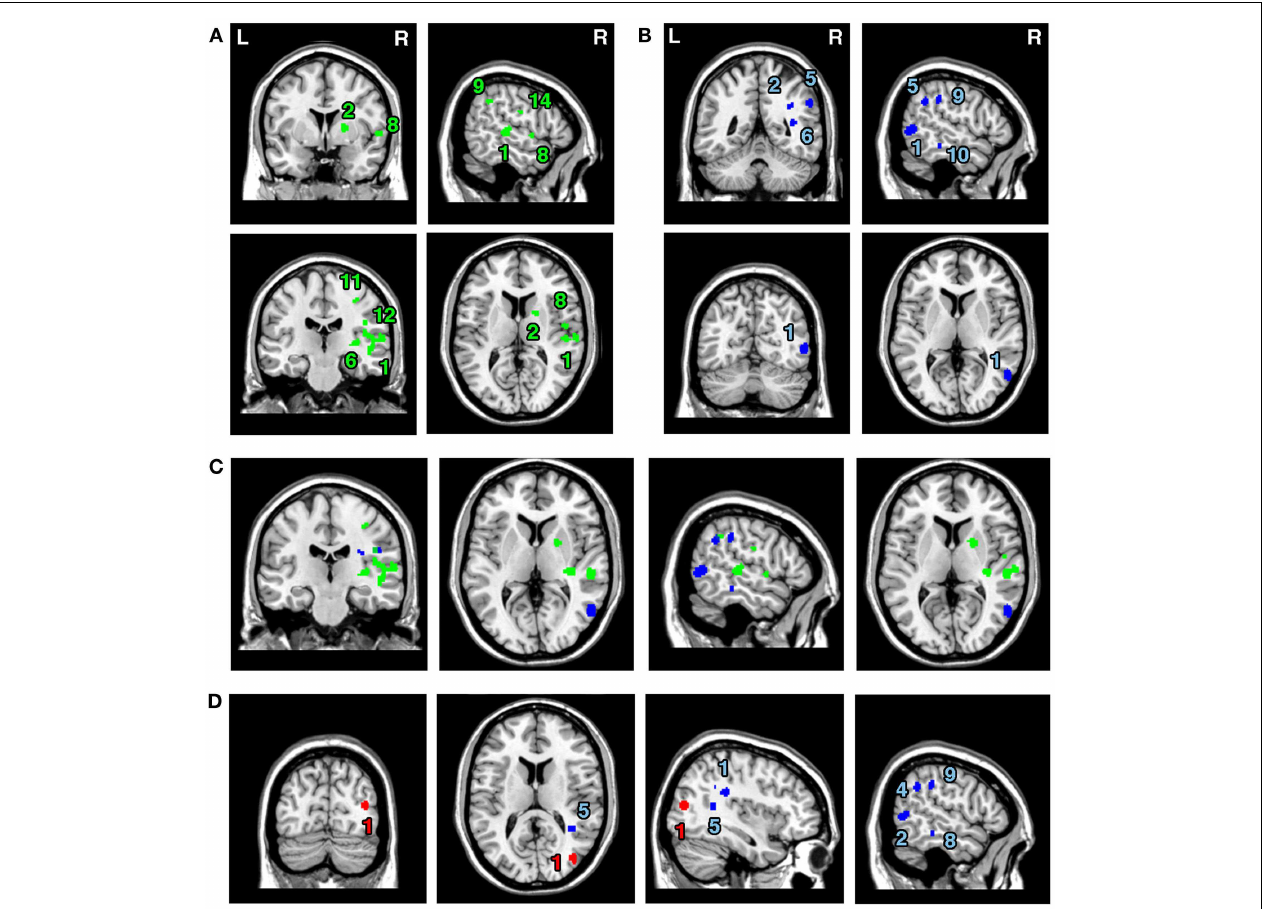
Distribution of ALE clusters indentified in both analyses ( Analysis 2 in green and Analysis 3 in blue). (D) The concurrence in lesions associated with either impaired performance on line bisection (red; Analysis 4 ) or impaired control of attention within objects, i.e., allocentric frame of reference as measured by various neglect diagnostic tests excluding line bisection ( Analysis 5 ; blue).The numbers in (A,B,D) denote indentified ALE clusters as listed in Table 3